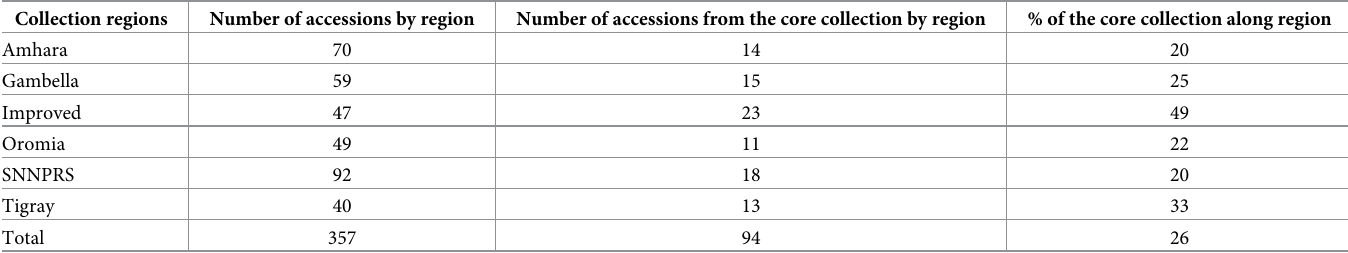
Table 4. Number and proportion of accessions in the core collection along with each collection